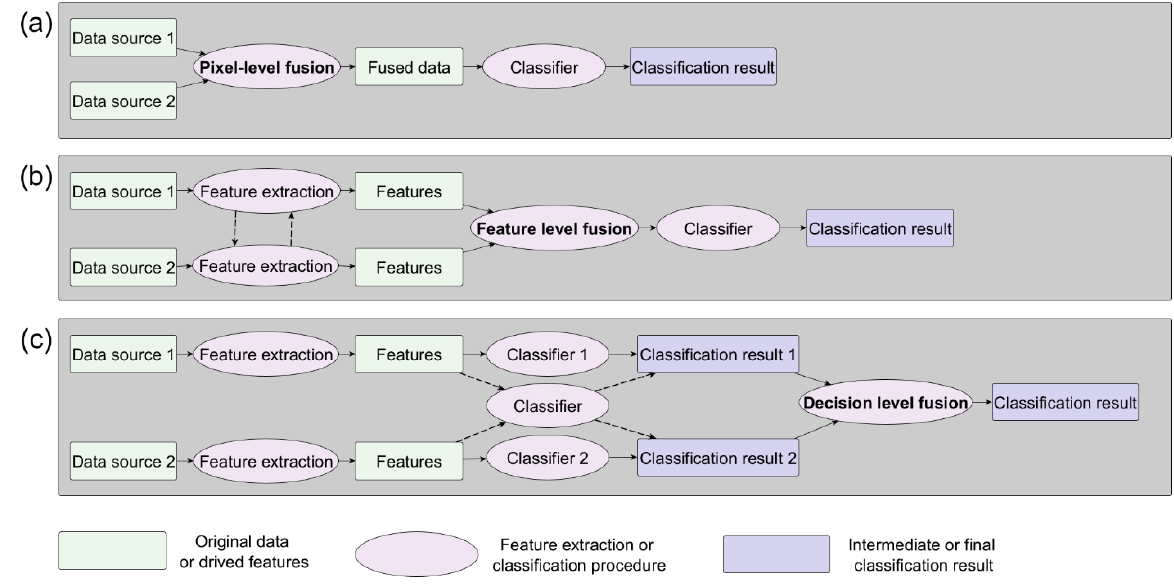
Figure 4. Data fusion for classification can be performed at the ( a ) pixel level, ( b ) feature level, and ( c ) decision level. Dashed lines represent alternative paths in contrast to solid lines.